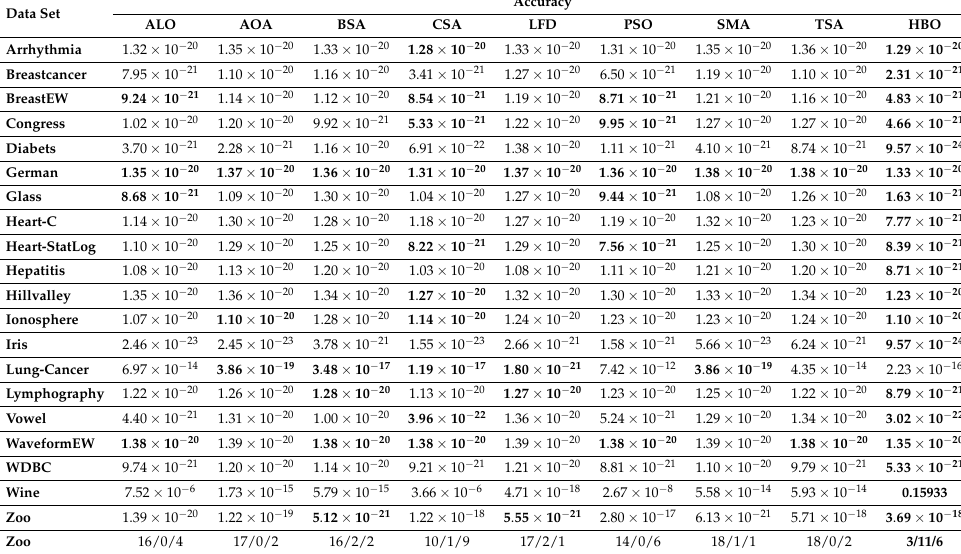
Table 10. Wilcoxon ranksum Statistical test based on Accuracy.